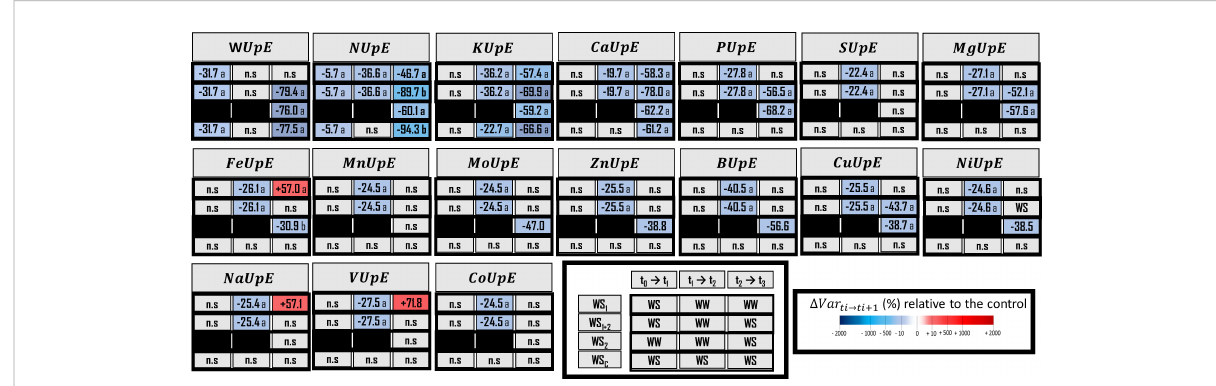
FIGURE 3 Water (WUpE) and element uptake ef fi ciency (EUpE) for macronutrients, micronutrients and three bene fi cial elements. Elements (E) characterized are N, nitrogen; K, potassium; Ca, calcium; P, Phosphorus; S, Sulfur; Mg, Magnesium; Fe, Iron; Mn, Manganese; Mo, Molybdenum; Zn, Zinc; B, Boron; Cu, Copper; Ni, Nickel; Na, Sodium; V, Vanadium, and Co, Cobalt. The effect of each treatment (WS 1 , transient vegetative stress; WS 1+2 , recurrent stress; WS 2 , transient reproductive stress; WS c, continuous stress) was expressed relatively to control plants (WW c ) at each harvest (t 1 , t 2 , t 3 ) ( D Var t i ! t i+1 ). Boxes were colored in red when the treatment induced an increase of the variable, and in blue when the treatment induced a decrease of the variable compared with conrol plants (WW c ); the intensity of the effect was characterized by the scale of color and the value (percent compared with WW c ) present in the box. Data are presented as a percentage relative to control plants ( n = 4 or n = 5). Primary data are available in Supplementary Table S4. Letters regroup treatments with non-signi fi cant difference for each